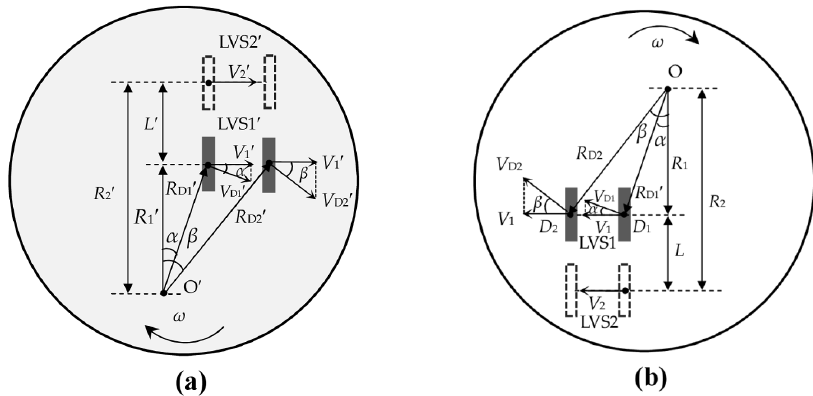
Figure 3. Relations of the rotational velocity ω with the linear velocities on ( a ) the terminal plane and ( b ) the image plane.